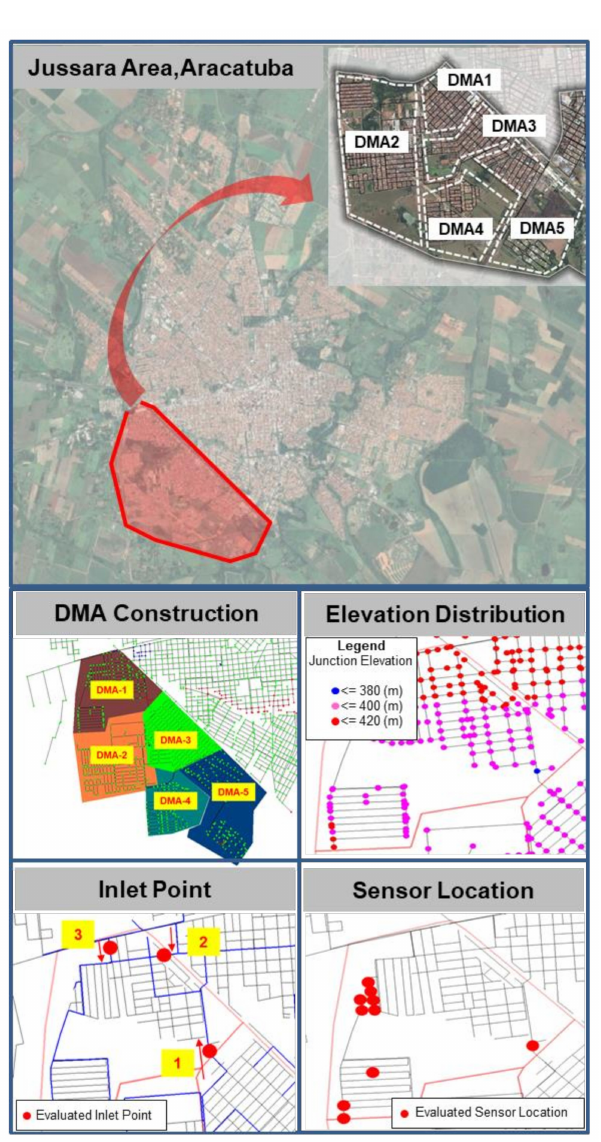
Figure 6. DMA design and information for the Jussara area,